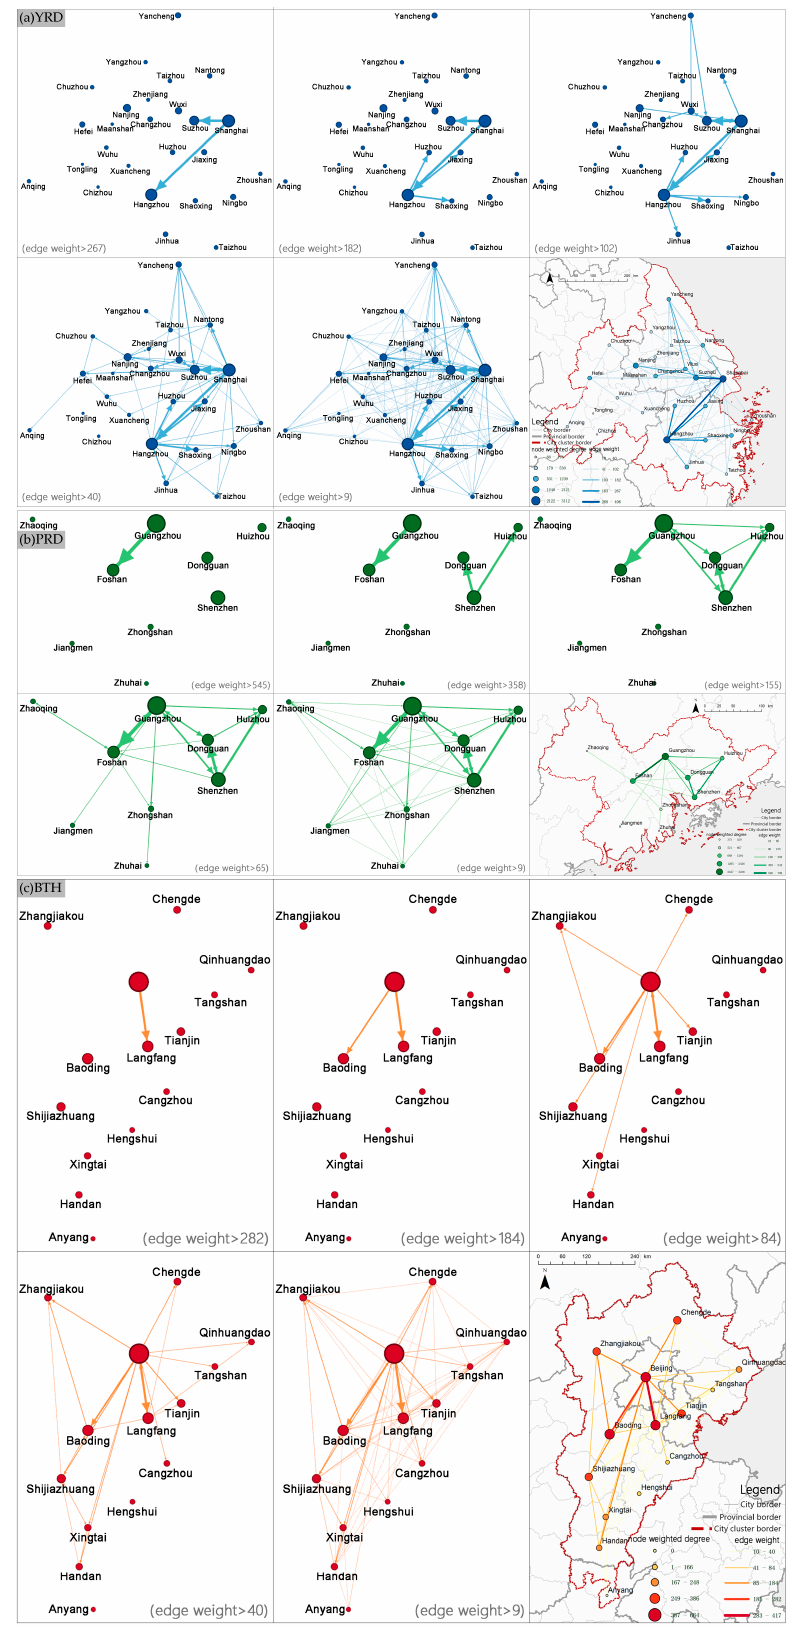
Figure 5. Topology and spatial distribution of the check-in networks of three major urban agglomerations ( a ), YRD; ( b ), PRD; ( c ), BTH).